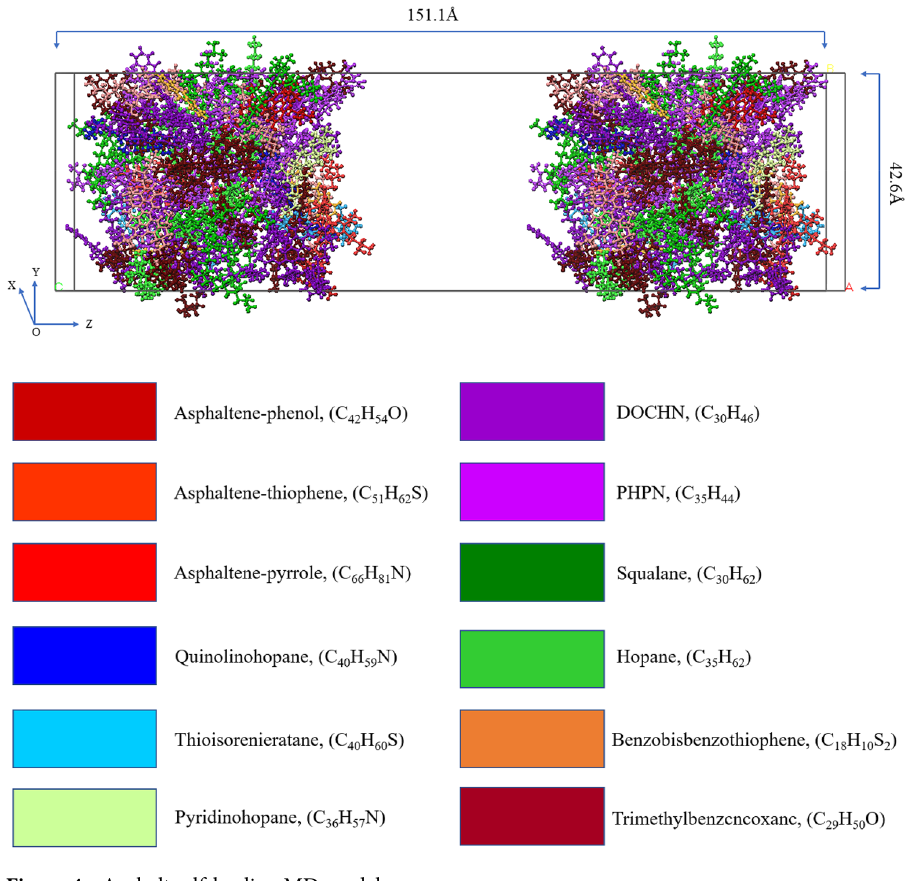
Figure 4. Asphalt self-healing MD